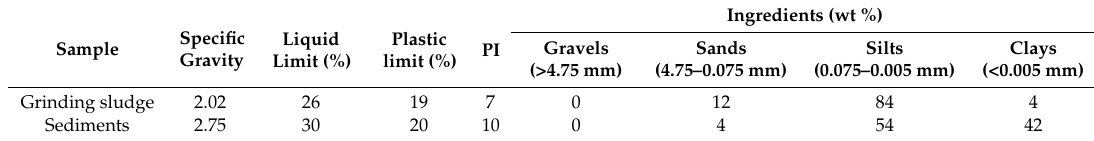
Table 3. Physical test results of sludge and reservoir